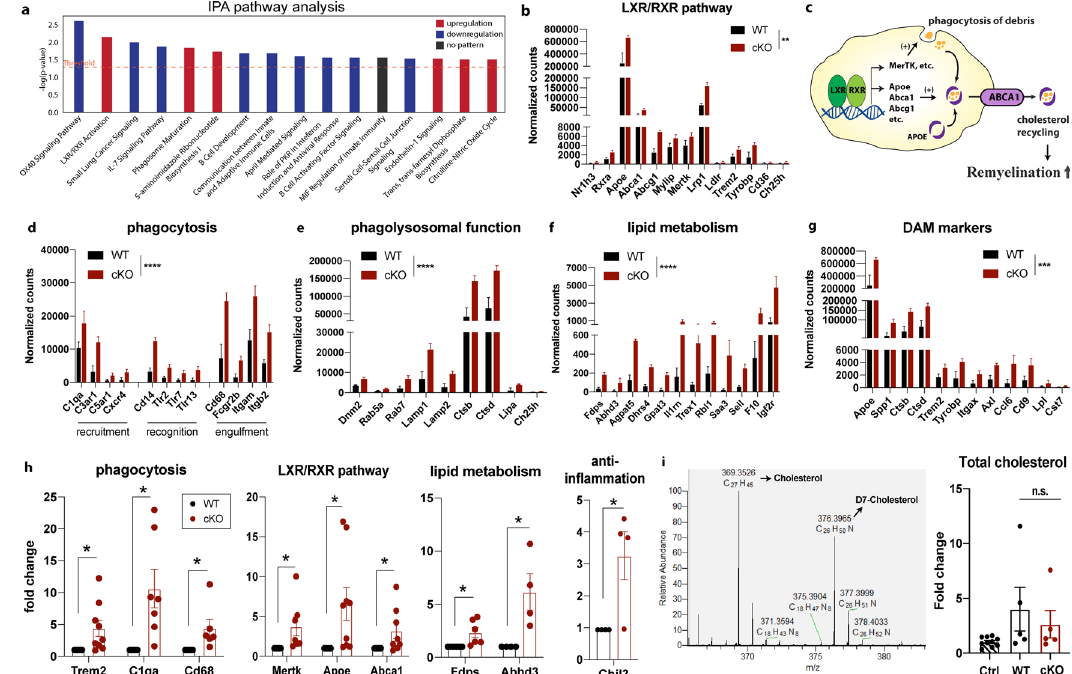
Fig. 3 Upregulated transcriptomes of phagocytosis and LXR/RXR activation in the Nhe1 cKO microglia. a Differentially up- and downregulated pathways from Ingenuity Pathway Analysis revealed elevated phagocytosis and LXR/RXR pathway activation in the cKO microglia. b Transcriptome analysis of genes regulated by LXR/RXR pathway in the IL hemispheres of WT and cKO microglia. c Illustration of the LXR/RXR activation in the regulation of phagocytosis and cholesterol metabolism. d – g Transcriptome analysis of genes relating to phagocytosis processes (recruitment, recognition, and engulfment), phagolysosomal function, lipid metabolism, and disease-associated microglia markers. N = 3 animals. h qPCR validation of genes for phagocytosis processes ( Trem2, C1qa, Cd68, Mertk ), LXR/RXR pathway activation ( Apoe, Abca1, Mertk ), lipid metabolism ( Fdps, Abhd3 ), and restorative microglial marker ( Chil3 , for Ym1 protein) in the P2RY12 + microglia. N = 4-9 animals. i Measurement of total cholesterol content (normalized to internal control D7- cholesterol) in isolated P2RY12 + microglia from WT and cKO brains at 3-day post-stroke by LC-MS. Nonstroke CL hemisphere was used as control (Ctrl). N = 5 biologically independent samples. Data are mean ± SEM. * p < 0.05, ** p < 0.01, *** p < 0.001, **** p <